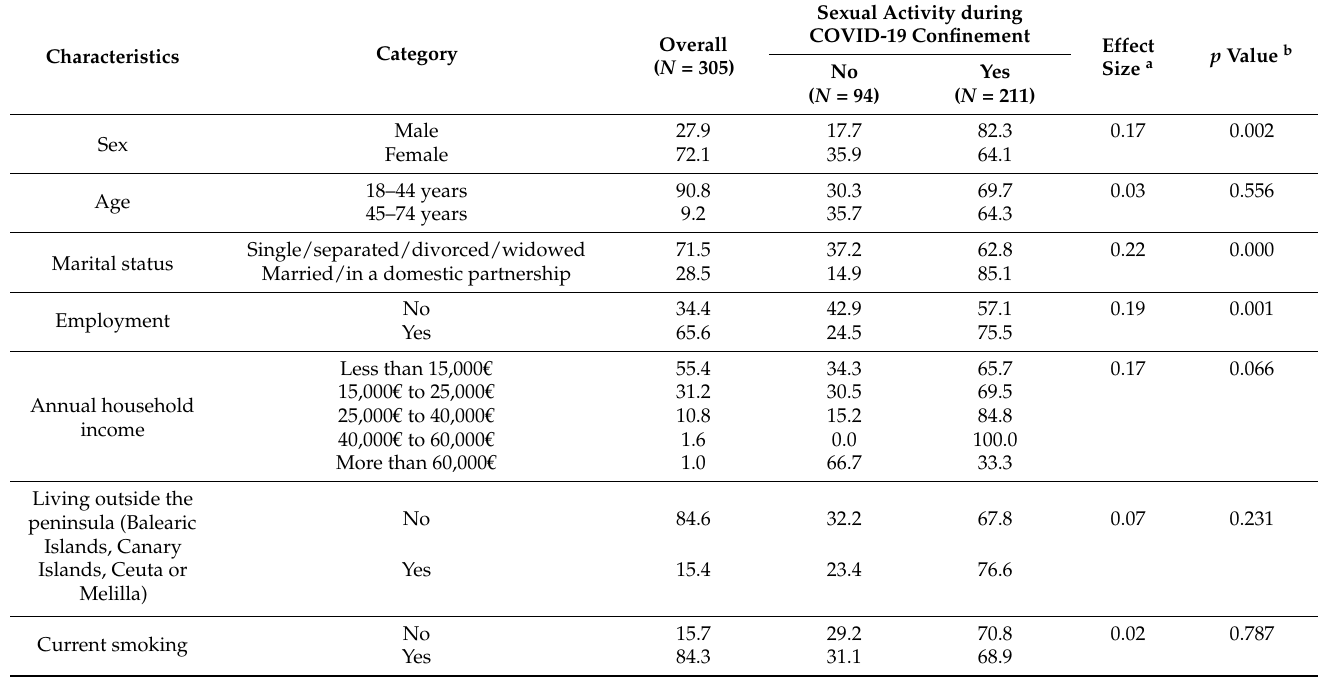
Table 1. Sample characteristics (overall and by sexual activity